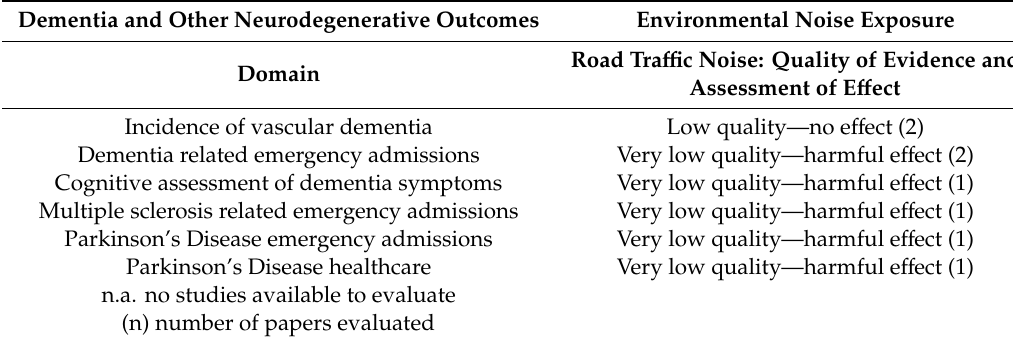
Table 9. Summary of the strength of the evidence for dementia and other neurodegenerative outcomes Dementia and Other Neurodegenerative Outcomes